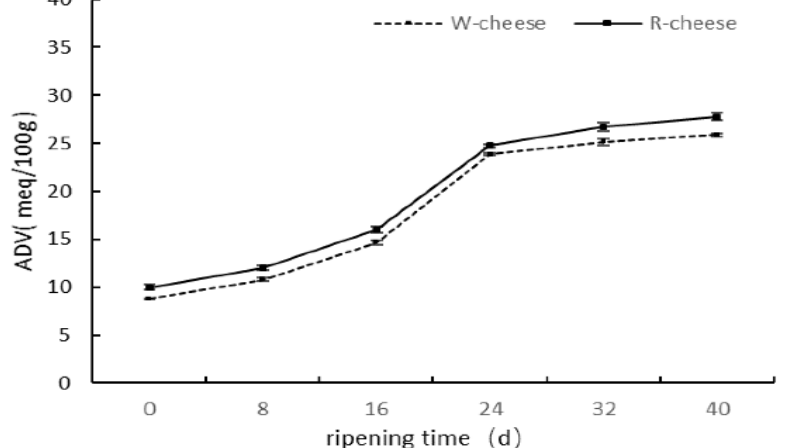
Figure 2. Content of individual free amino acid (FAA) of cheeses with different ripening time. ( a ) 0 d; ( b ) 16 d; ( c ) 40 d.